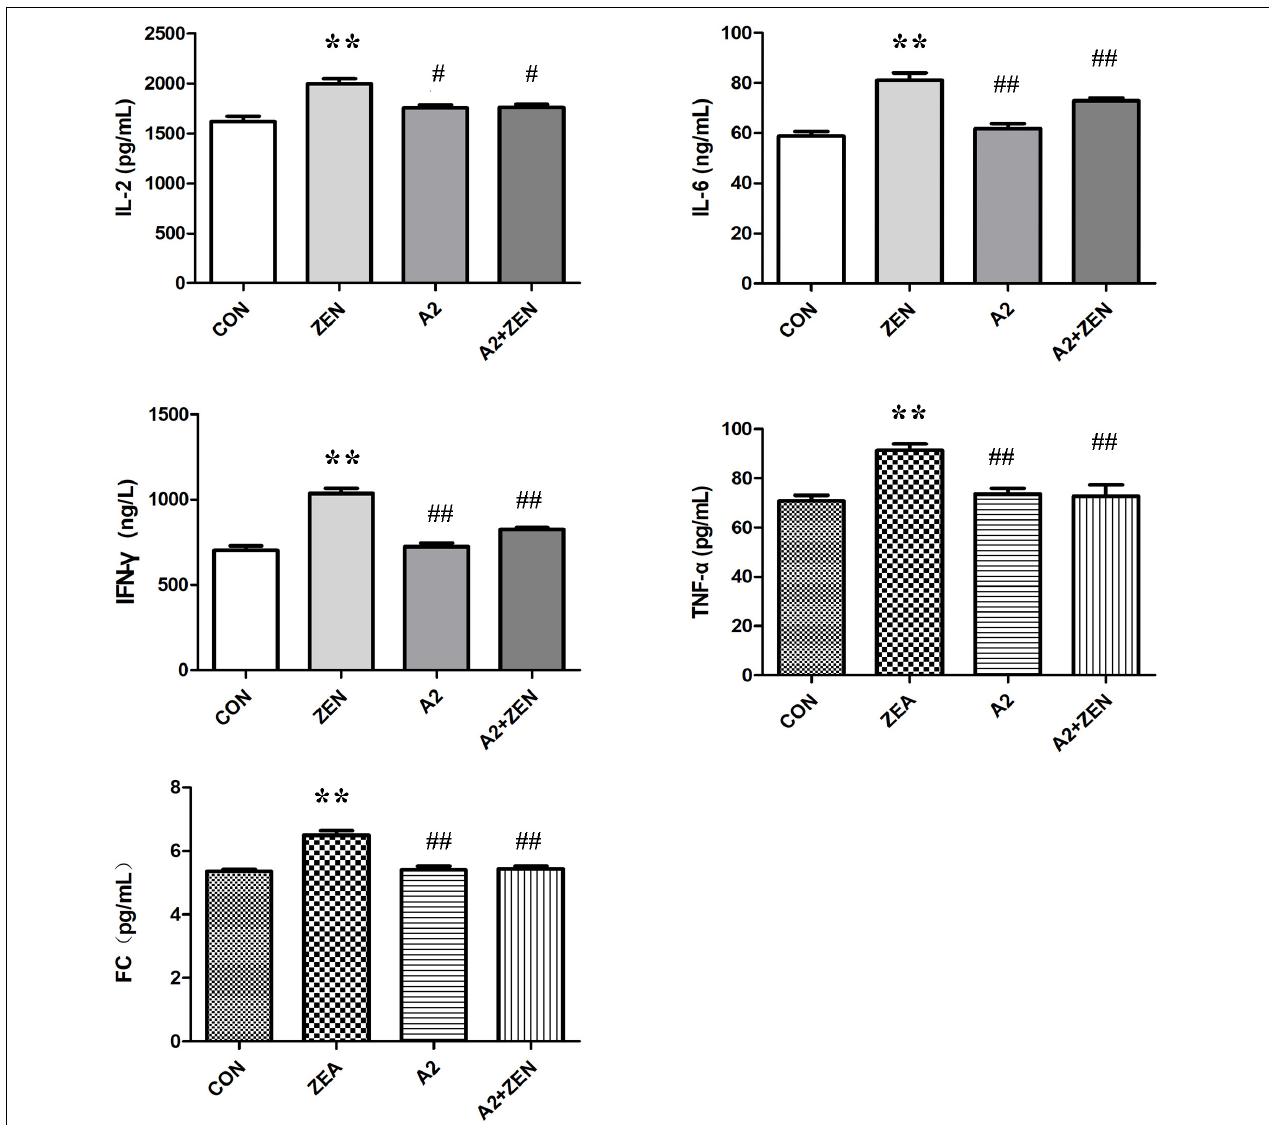
FIGURE 4 | Test results of cecum verification indicators in each group included four groups: the data in the figure all come from three independent repeated tests. "**" means an extremely significant difference compared with the CON group ( P < 0.01). "#" means a significant difference compared with ZEA ( P < 0.05), "##" means an extremely significant difference compared with ZEA ( P <